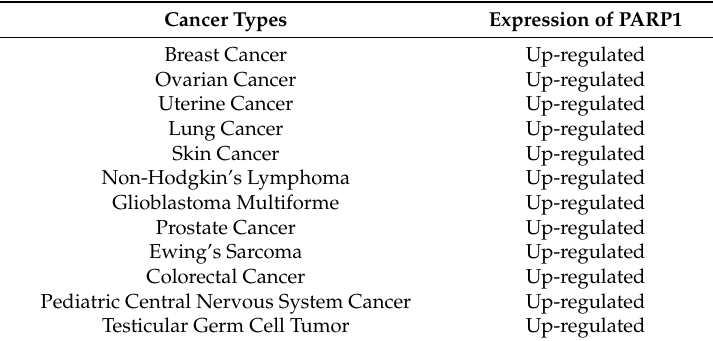
Figure 1. Structural characteristics of PARP1 and PARP1-based DNA repair. ( a ) Schematic representation of human PARP1 molecular architecture; ( b ) Structural process of PARP1-mediated DNA repair. After DNA-binding domain (DBD, blue ball) of PARP1 senses and binds damaged DNA, the NAD + will be cleaved into ADP-ribose and nicotinamide, which are catalyzed by the catalytic domain (CAT, yellow ball) of PARP1. Then, poly (ADP-ribose) (pADPr) is synthesized on the acceptor PARP1 through the combination of ADP-ribose, assisted by the catalysis of CAT too. Subsequently, PARP1 leaves damaged DNA, due to the dense negative charge of pADPr, allowing the recruitment of related repair proteins and replication. In chemical formulae, domains in yellow represents active domains of PARP1, while blue and black parts represent NAD + . Hydroxyl of Ser904 and carbonyl and NH group of Gly863 in PARP1 interact with the amide moiety of NAD + via hydrogen bonding interaction, while Tyr907 of PARP1 via π – π stacking interaction. The curved arrows in blue represent the nucleophilic attack by the 2 ′ -hydroxyl of the acceptor site in PARP1, and the release of the nicotinamide procedures; AD, orange ball; WGR, red ball. ( c ) The PARP1/damaged DNA crystal structure. Zn1, dark green; Zn2, silver (left); Zn3, light green; BRCT, silver (right); ART, dark yellow; HD, light yellow; red, WGR [4,18,19]. Table 1. Expression level of PARP1 in different carcinomas.